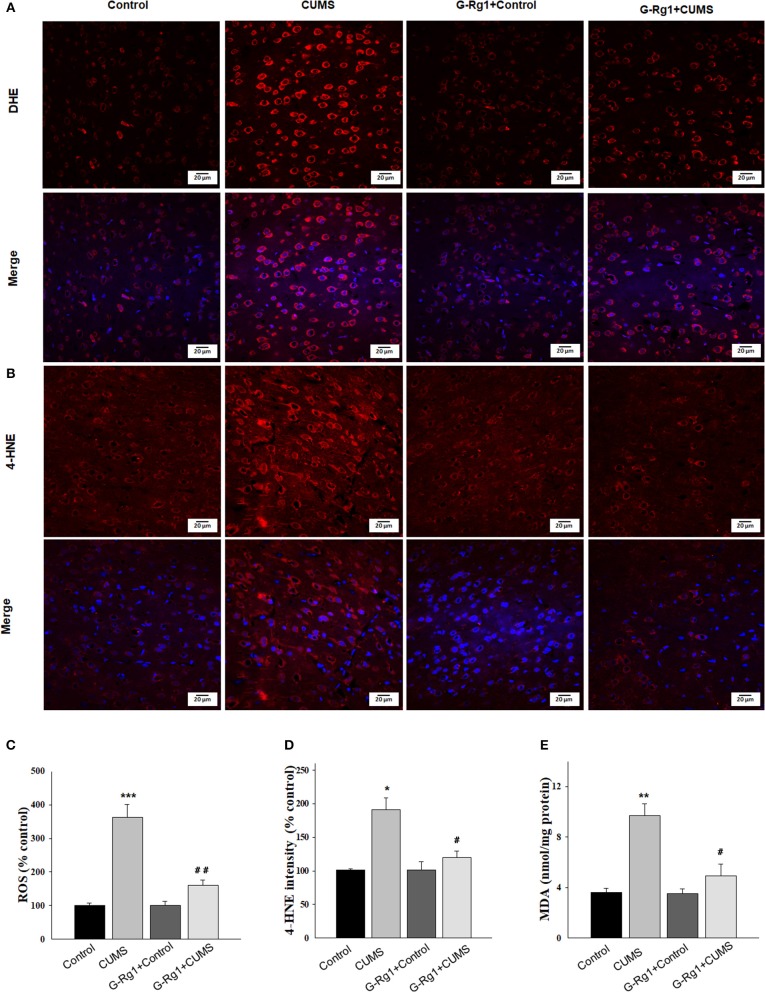
Ginsenoside-Rg1 attenuated oxidative stress in vmPFC neurons as induced by CUMS exposure. (A) Representative images of DHE staining (red) within the vmPFC area from each group rats for ROS analysis. Nuclei (blue) are stained with DAPI. Scale bar is 20 μm. (B) Representative images of 4-HNE staining (red) vmPFC area from each group rats. Nuclei (blue) are stained with DAPI. Scale bar is 20 μm. (C) Bar graph illustrating the quantitative data of relative fluorescence of ROS within the vmPFC area of rats. Values are expressed relative to those of the control group. N = 6 per group. (D) Bar graph illustrating the quantification of 4-HNE within the vmPFC area of rats. Values are expressed relative to those of the control group. N = 6 per group. (E) MDA analysis was performed and levels were normalized to the protein content. N = 10 per group. Data were presented as the means ± SEM. *P < 0.05, **P < 0.01, ***P < 0.001 CUMS vs. Control group; #P < 0.05, ##P < 0.01 G-Rg1+CUMS vs. CUMS group. G-Rg1, Ginsenoside-Rg1.